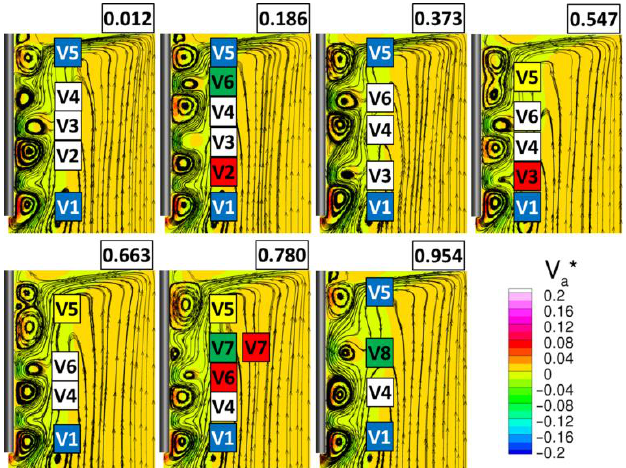
Figure 15. Evolution of the flow structure during a period for regime 6 (case with Re i = −442 and Re o = 420). Considering the vortices between V1 and V5, the common trend is a downward movement (white background color), this drives the suppression of V2 and the generation of V6 at 18.6% of the period (respectively highlighted with red and green background colors). The descent of the vortices continues inducing the suppression of V3 and driving the opportunity for V5 to extend, as previously described. When V5 retracts (78% of the non-dimensional period), V7 is generated and acts in the way of suppress and be suppressed by V6. The space left by the mutual suppression of V6 and V7 induces the generation of V8. Finally, V4 and V8 move downward at 95.4% of the period entailing the birth of what was referred to as V4 at the beginning of the process.